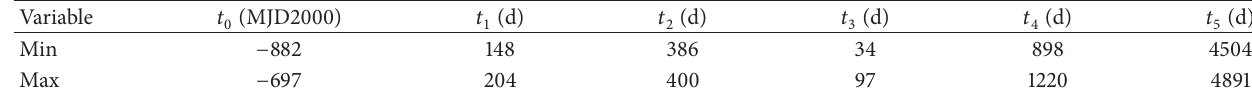
Table 4: Value range of the fourth community in Cassini.